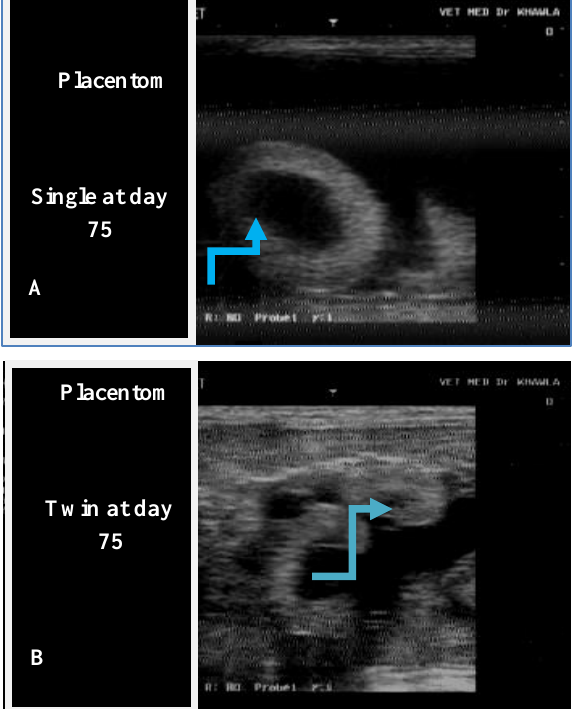
Figure, 4: Placentom size at days 75 of pregnancy in Shami goats . (Advance stage).